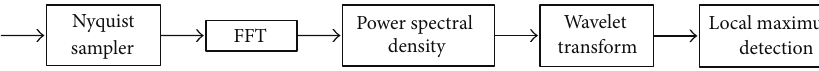
Figure 14: Block diagram of Wavelet transform-based technique.